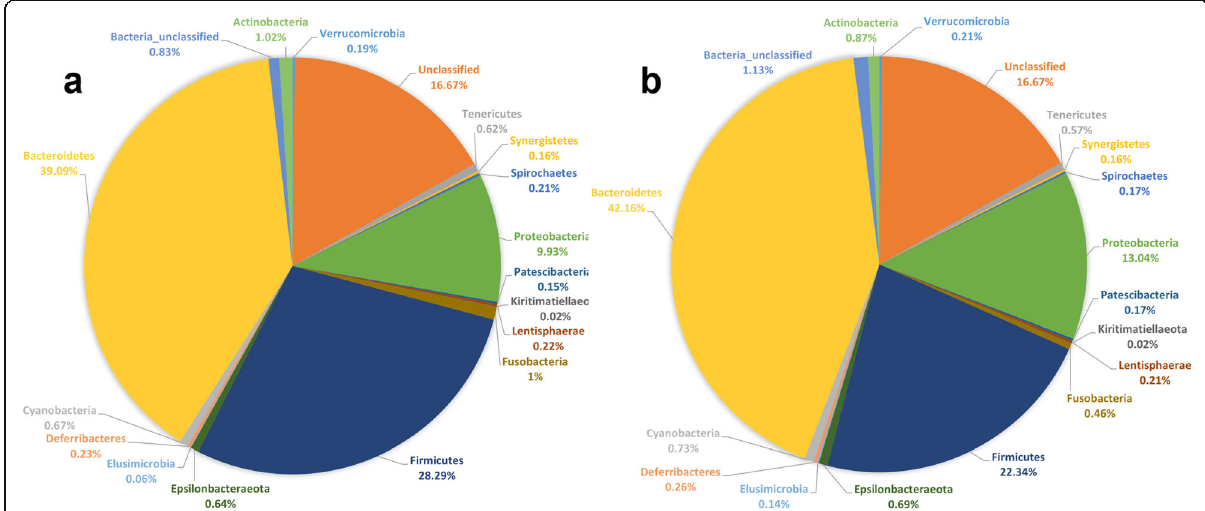
Fig. 1 Overall gut microbiota composition at the phylum level affected by probiotic supplementation. a). Microbial abundance (%) in the control flock. b). Microbial abundance (%) in the probiotic supplemented flock. For direct comparison between the control and probiotic supplemented groups, data obtained from the samples collected between day 1 and week 36 of flock age were analysed as a pool. For percent calculation of microbial abundance at phylum level, total sum scaling normalised but untransformed data obtained from Calypso software were visualised in Excel 2016 and the panel graphs were prepared in Graphpad prism v.